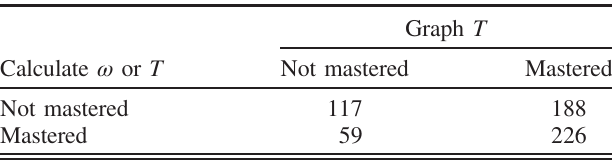
TABLE V. Cross tabulation for the mastery of graph T and calculate ω or T skills. Here we see indication of the hierarchy calculate ω or T → graph T .